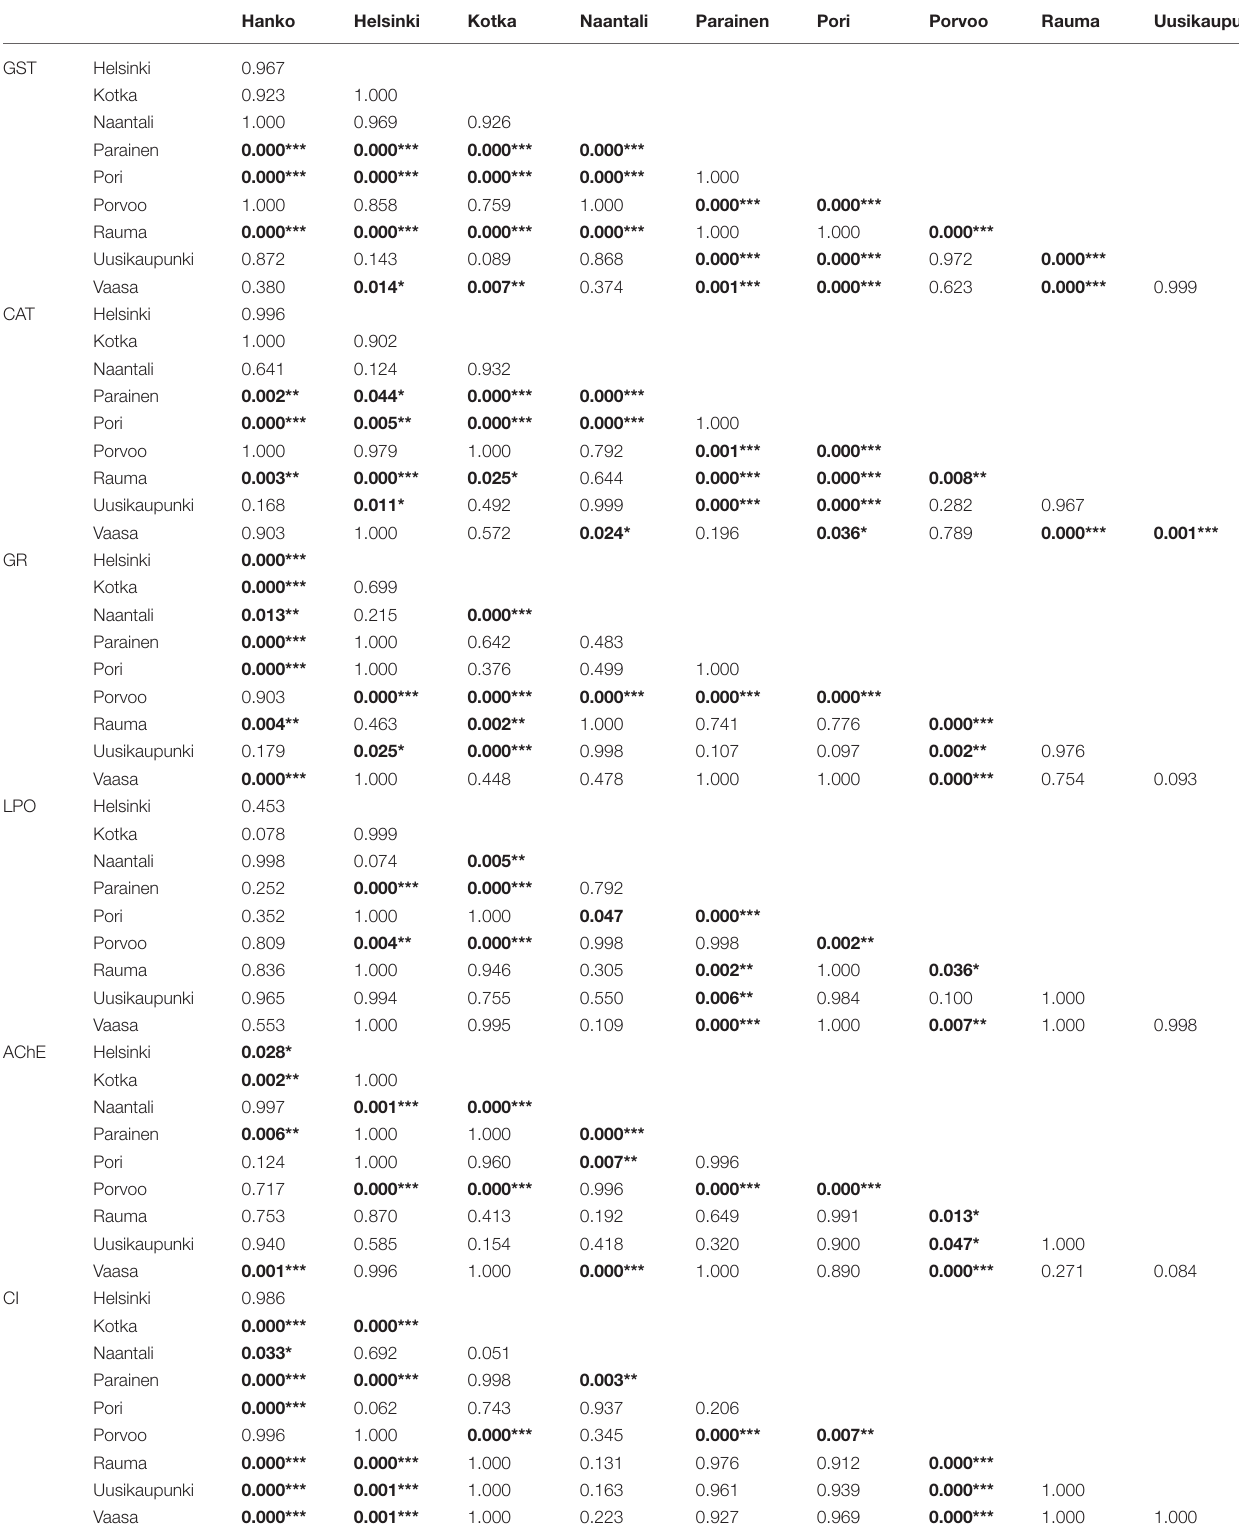
TABLE 4 | ANOVA performed on each biomarker at the different study locations with post hoc Tukey’s HSD multiple comparisons.